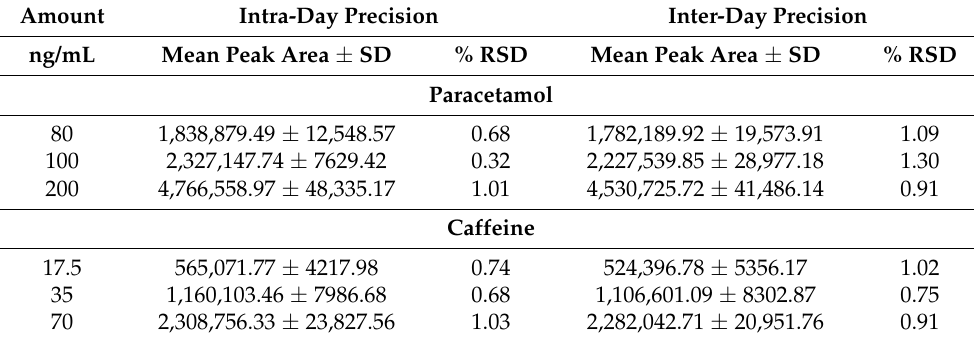
Table 3. Precision of UPLC method for the concurrent quantification of PCM and CAF.